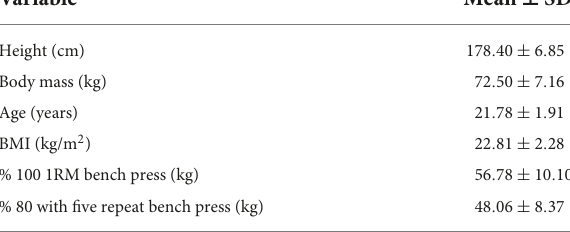
TABLE 2 Descriptive statistics on the demographic data of the participants.